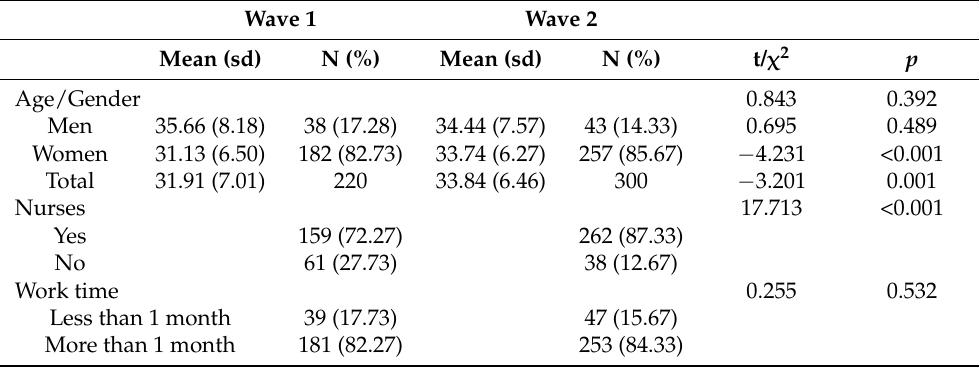
Table 1. Demographic characteristics of the samples of Wave 1 and Wave